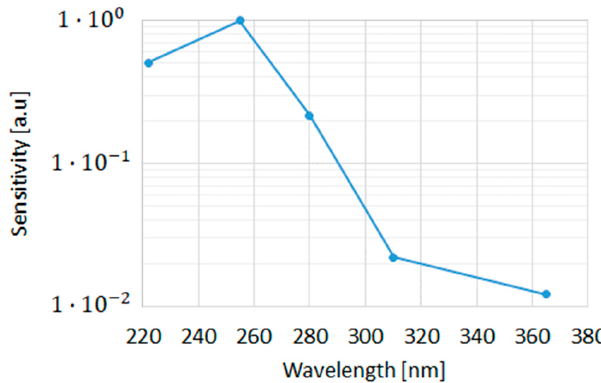
Figure 8. Grill C-Sensor normalized sensitivity for different UV wavelengths.